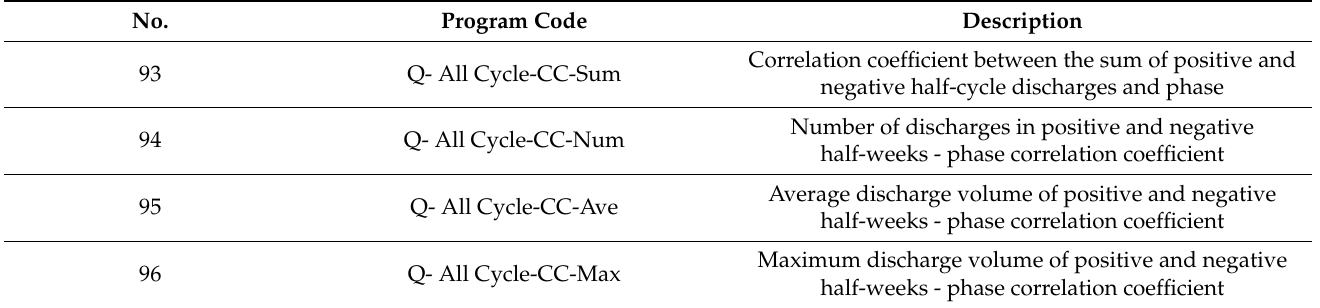
Table 2. Partial discharge characteristic parameters: modified cross-correlation